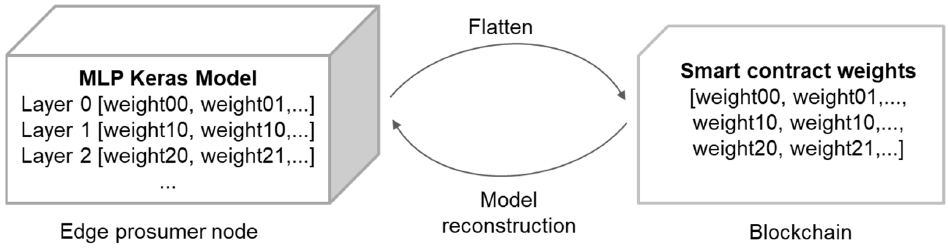
Figure 7. Keras model integration for reduced smart contracts complexity.